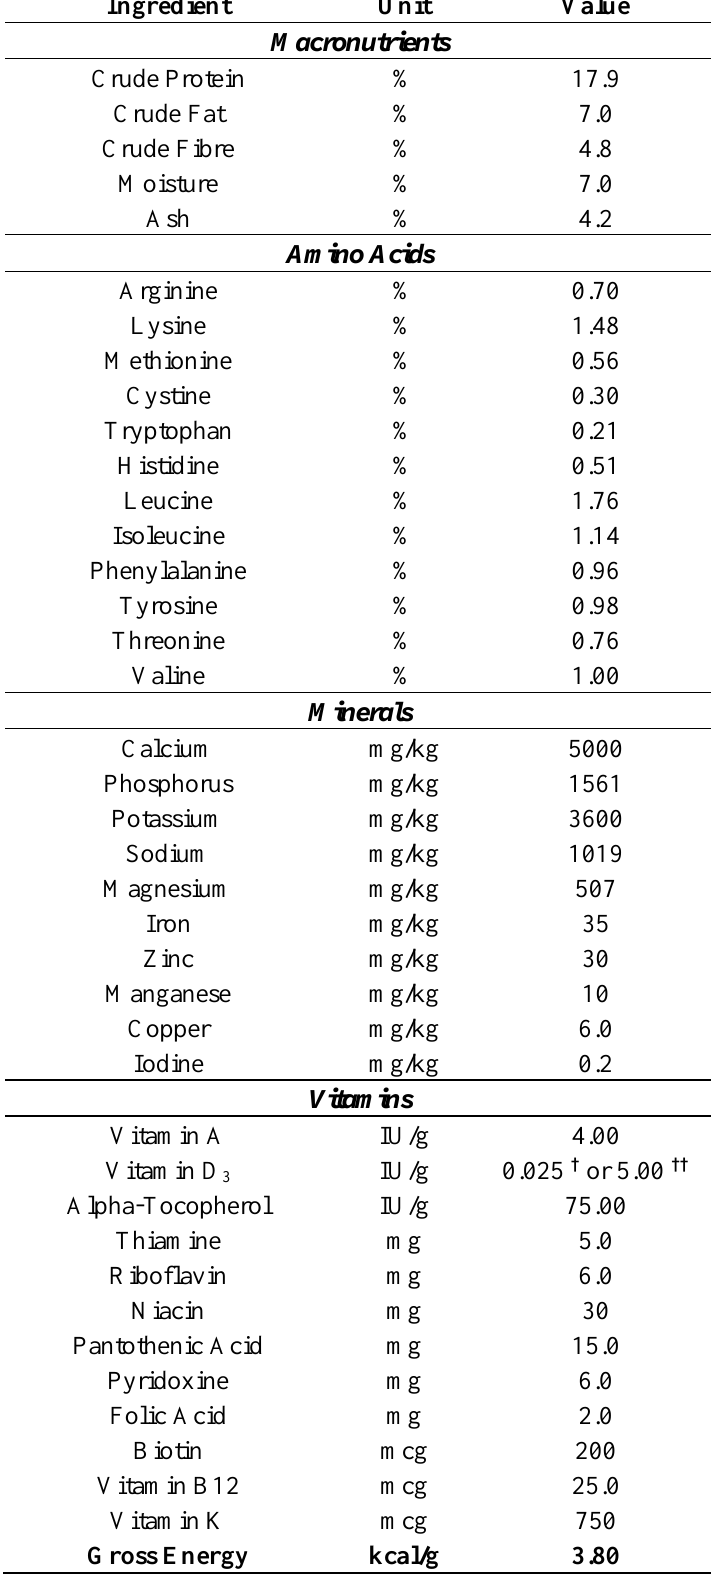
Table 1. Composition of modified AIN93G purified rodent diet containing high or low levels of vitamin